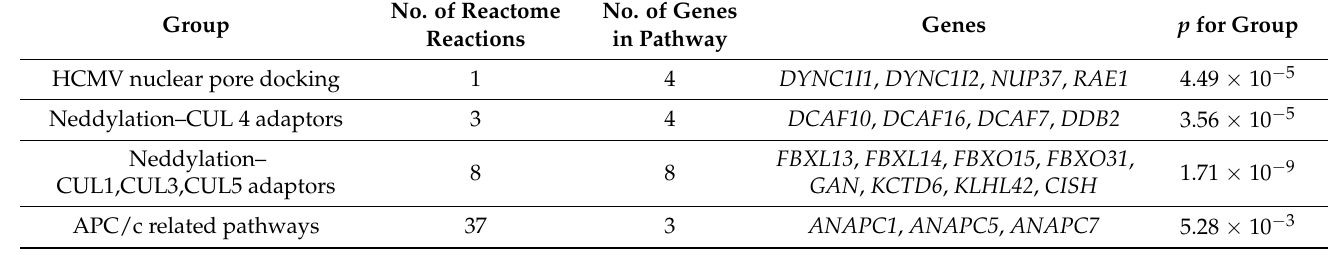
Table 7. Main Reactome reactions over-represented by ubiquitin E3 ligase adaptor genes depicted in Figure 14.